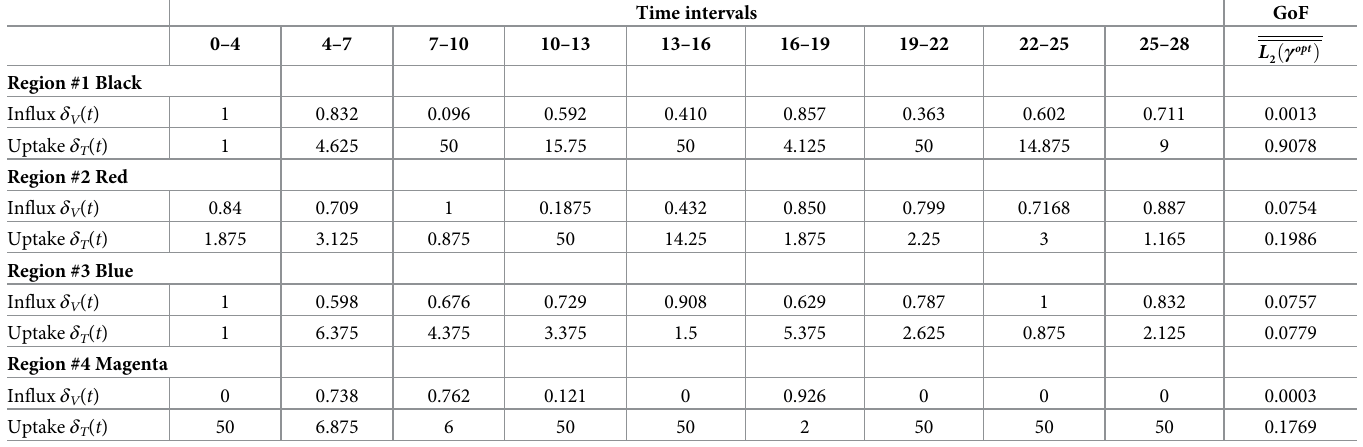
Table 2. Influx and Uptake Schedules for four considered ROIs.